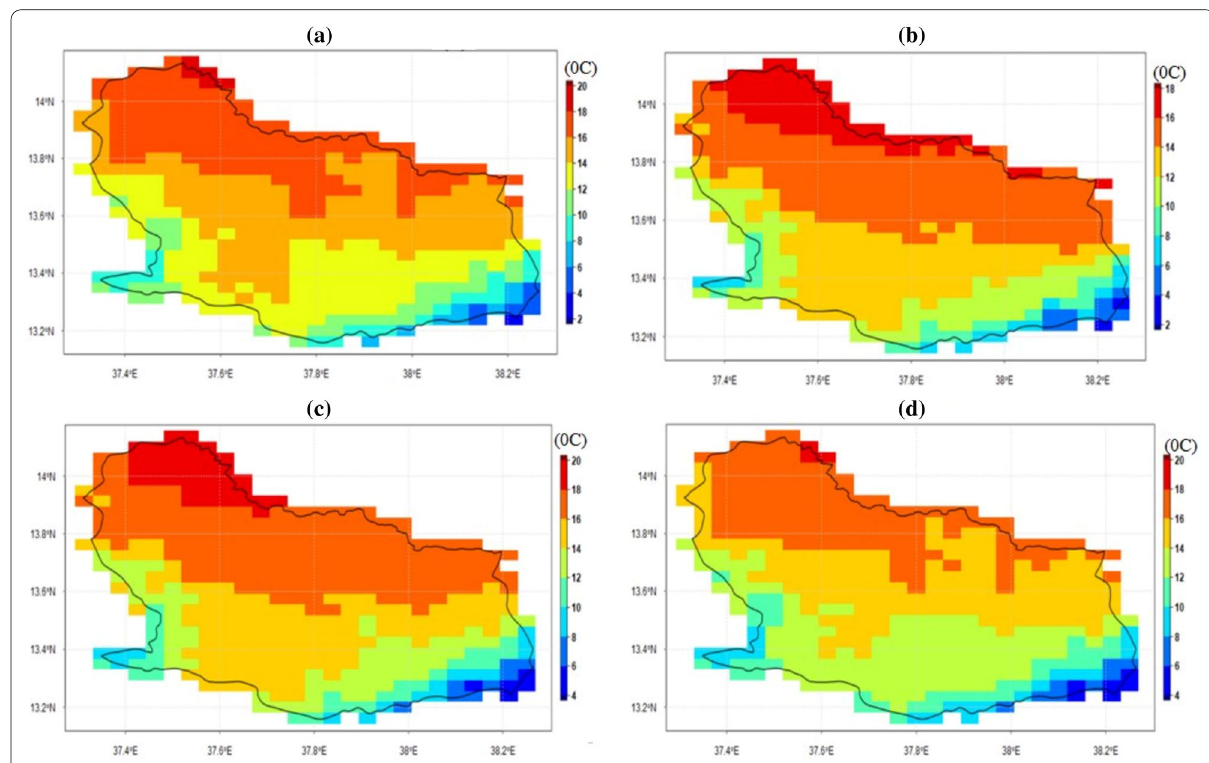
Fig. 11 Mean annual and seasonal minimum temperature: Annual ( a ), Bega season ( b ), Belg season ( c ) and Kiremit season ( d ) at Zarima